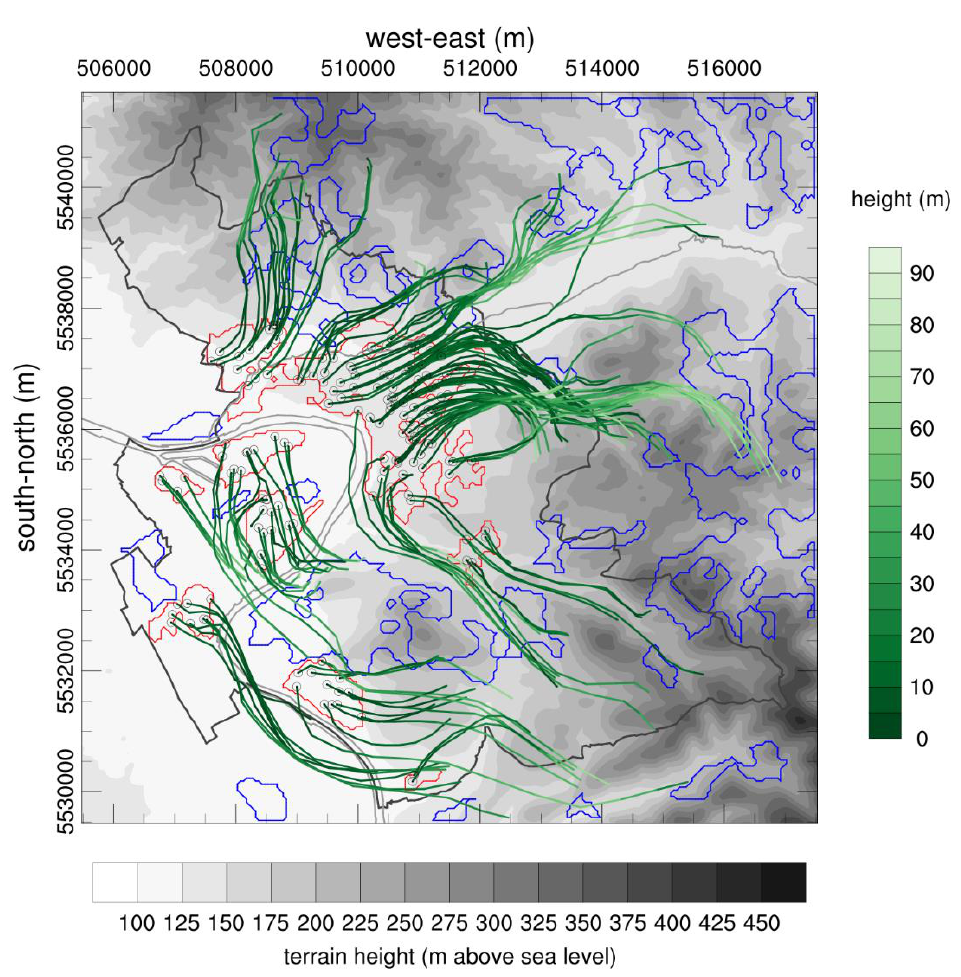
Figure 9. Backward trajectory map of the 12 km × 12 km subdomain from 01:00 to 23:00 CEST with trajectory heights above ground level in green color shading. Trajectories are released in the thermal hot spots (red contour) identified by z-transformation. Additionally shown are the cold air formation areas in blue, rivers in light grey, the city border of Aschaffenburg in black lines and terrain elevation in grey color shading.